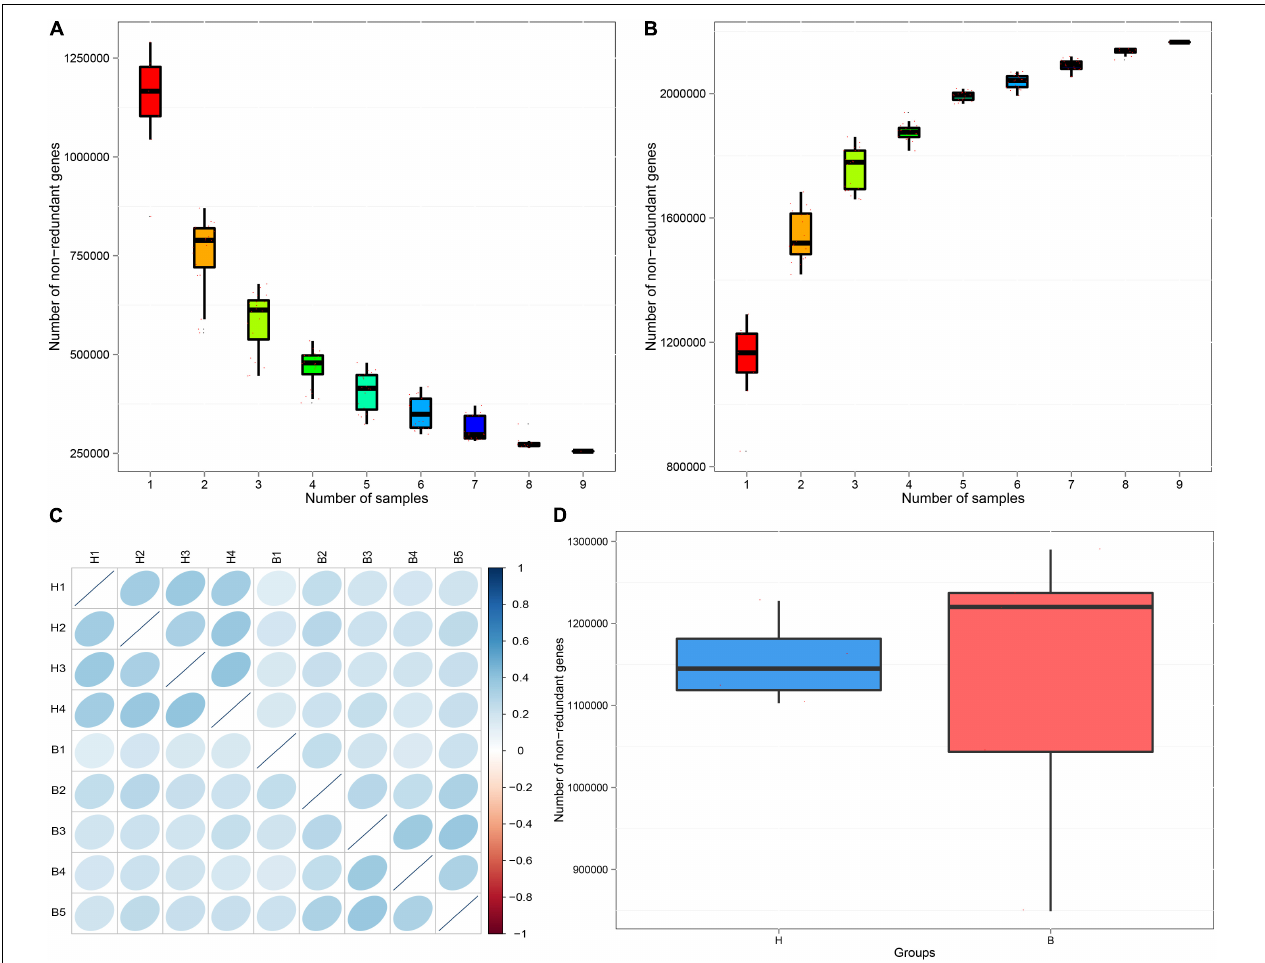
FIGURE 1 | Rarefaction curves of (A) core genes and (B) pan genes. The horizontal axis represents the number of samples selected; the vertical axis represents the number of genes in the selected sample combinations. (C) The heatmap of correlation coefficients. The deeper the color, the greater the absolute value of the correlation between samples. (D) Box-plot diagram of gene number difference between groups. The horizontal axis represents the grouping information; the vertical axis represents the number of